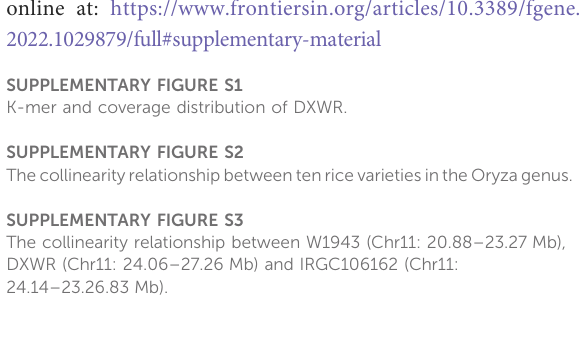
SUPPLEMENTARY FIGURE S1 K-mer and coverage distribution of DXWR. SUPPLEMENTARY FIGURE S2 ThecollinearityrelationshipbetweentenricevarietiesintheOryzagenus. SUPPLEMENTARY FIGURE S3 The collinearity relationship between W1943 (Chr11: 20.88 – 23.27